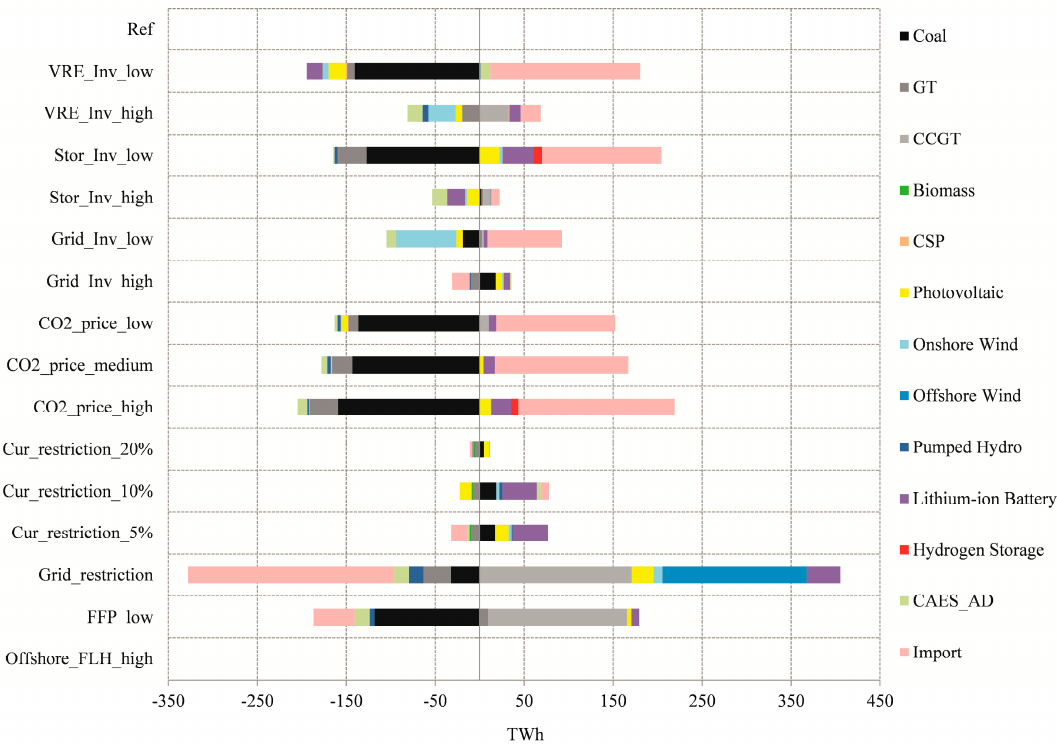
Figure 16. Sensitivity analysis on annual electricity generation of 2050 in BTH shown as deviations from the reference scenario.